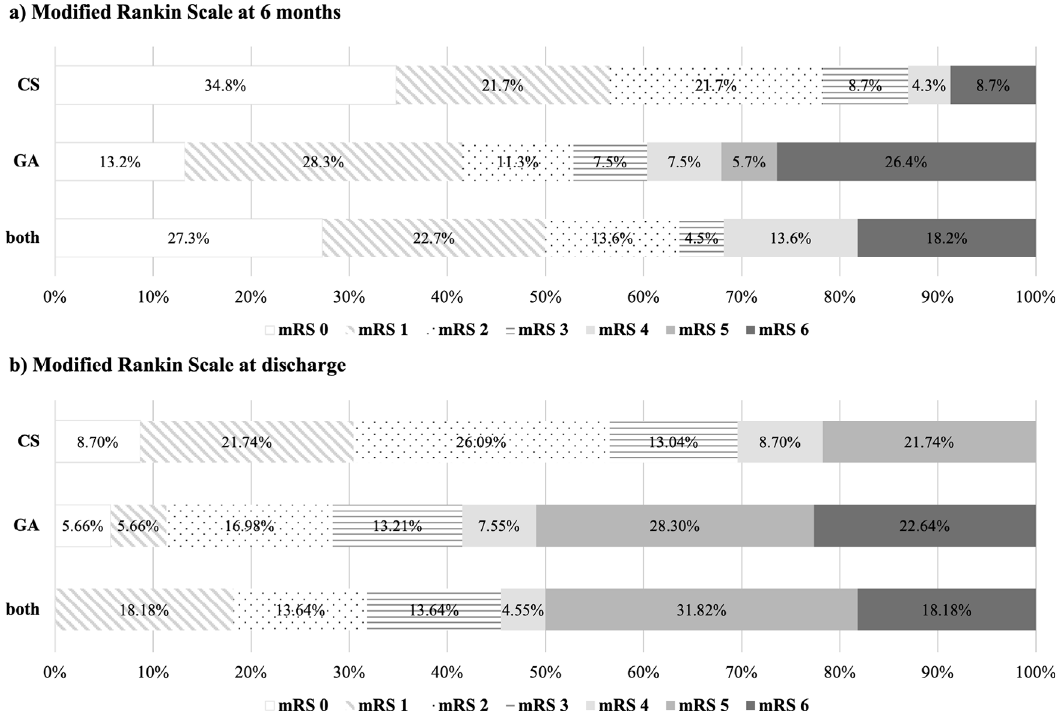
Figure 1.Distribution of modifiedRankinScale(mRS)categories according to anesthesia modality (Conscious Sedation = “ CS ” , General Anesthesia = “ GA ” and Conscious Sedation as well as General Anesthesia = “ both ” ). Numbers represent the percentages for each mRS category per group. a) “ CS ” , “ GA ” and “ both ” at six-month follow up. b) “ CS ” , “ GA ” and “ both ” at discharge from hospital.